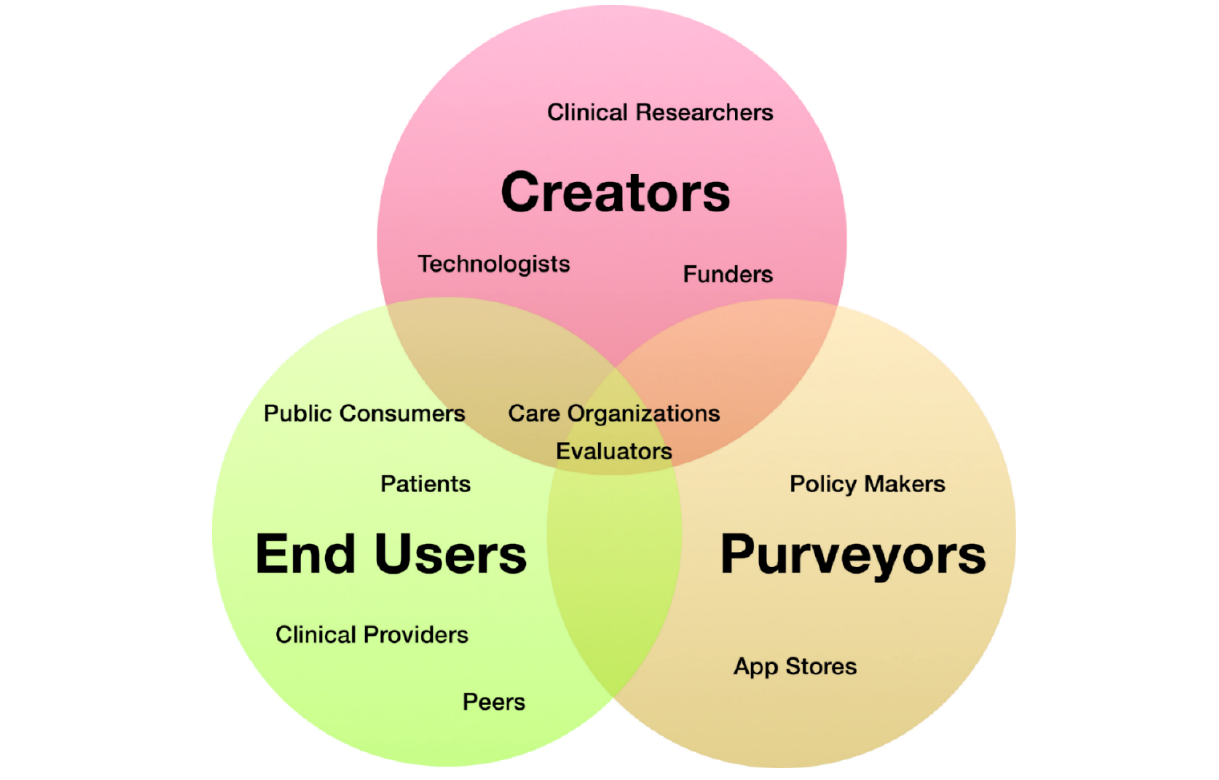
Figure 1. Stakeholders involved in